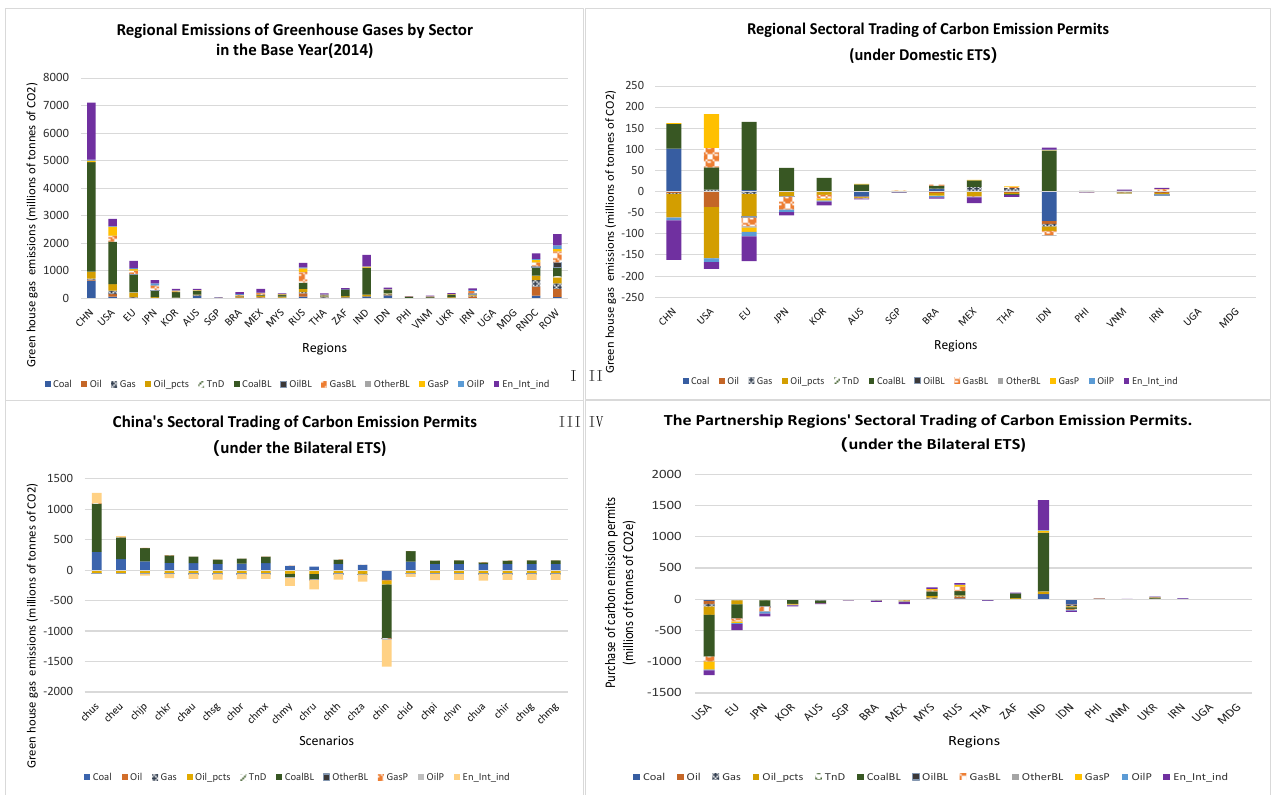
Figure 4. Emissions and carbon emissions permit trading at the regional level by sector. ( I , IV ), regional greenhouse gas emissions by sector in 2014 ( I ) and under the domestic ETS scenario in 2030 ( II ); and sectoral trading of carbon emission permits under the bilateral ETS scenario in China ( III ) and its partnership regions ( IV ).